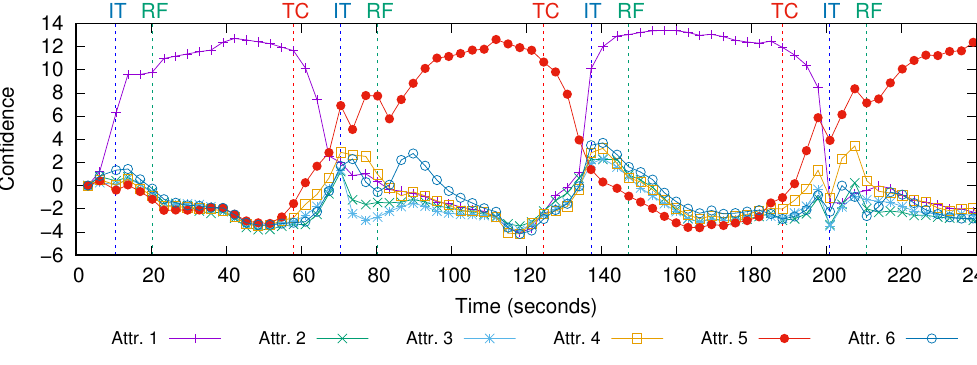
Figure 9. The confidence level of the